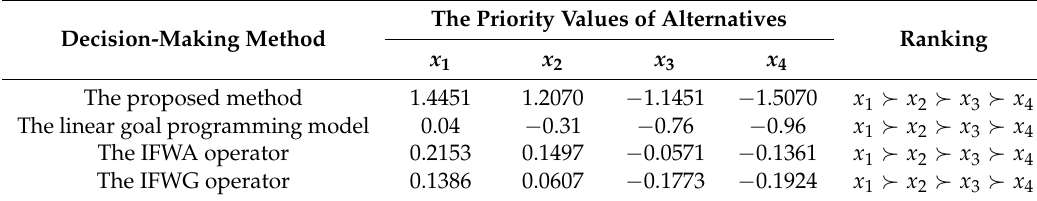
Table 1. Comparison result of Example